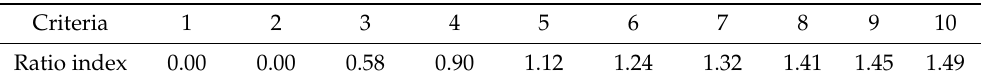
Table 3. RI values for number of